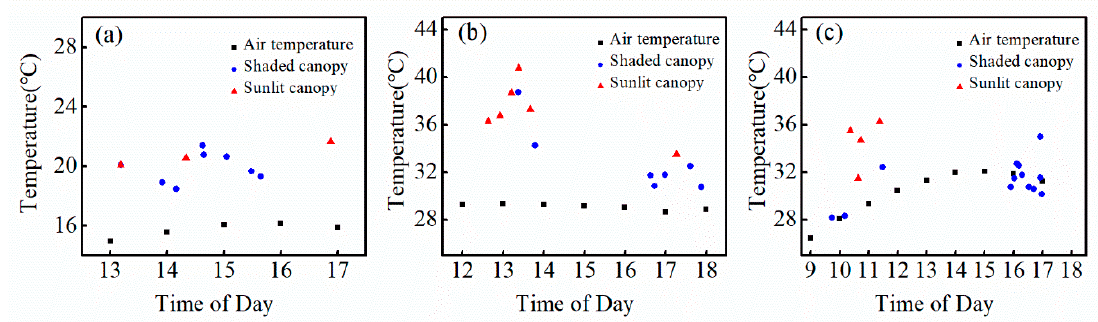
Figure 11. Comparison of canopy temperature and air temperature: ( a ) Data measured at Beijing